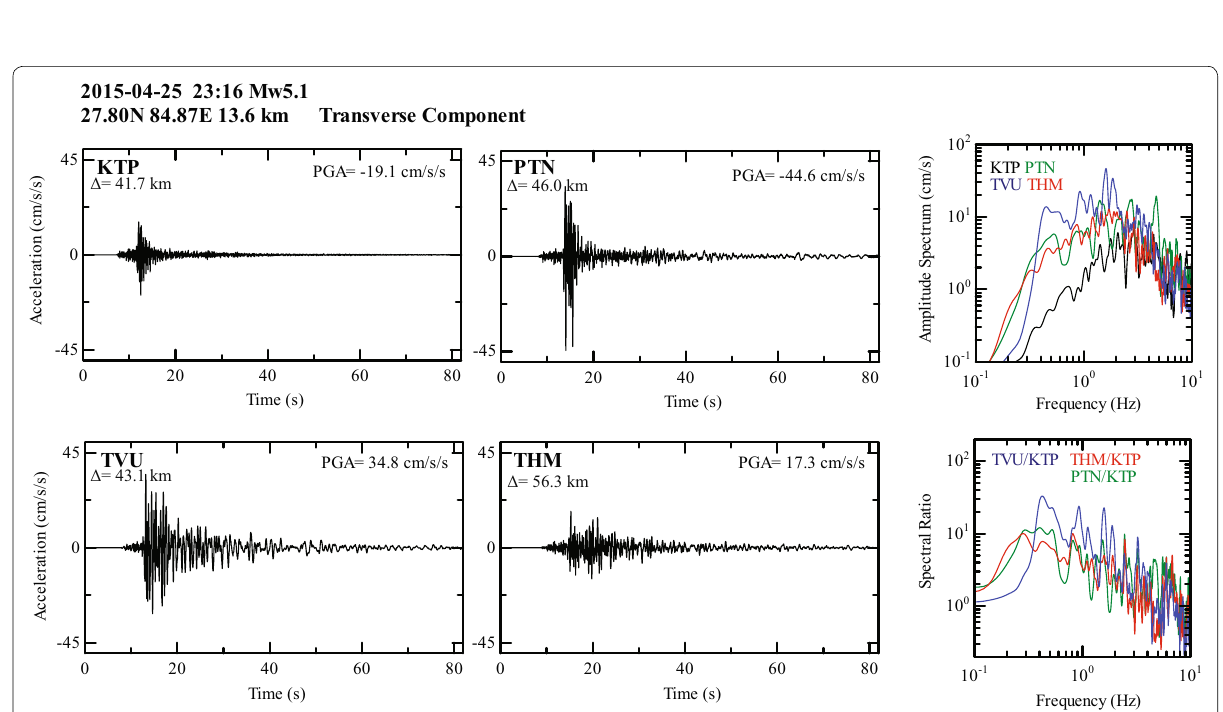
Fig. 4 Acceleration waveforms, Fourier spectra, and spectral ratios of the second Mw5.1 earthquake for the transverse component. The epicenter of this aftershock (April 25, 2015 23:16 UTC) is about 45 km west of